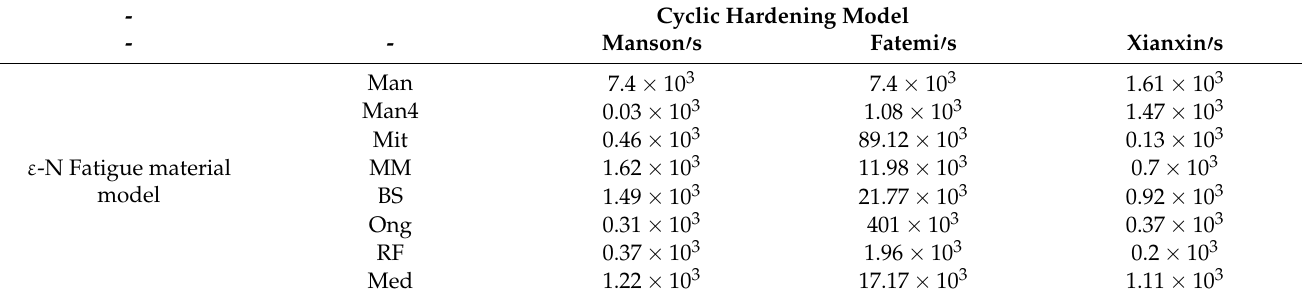
Table 5. Results of numerical fatigue life tests for the compressor blade with a notch tested in resonance conditions. - Cyclic Hardening Model -